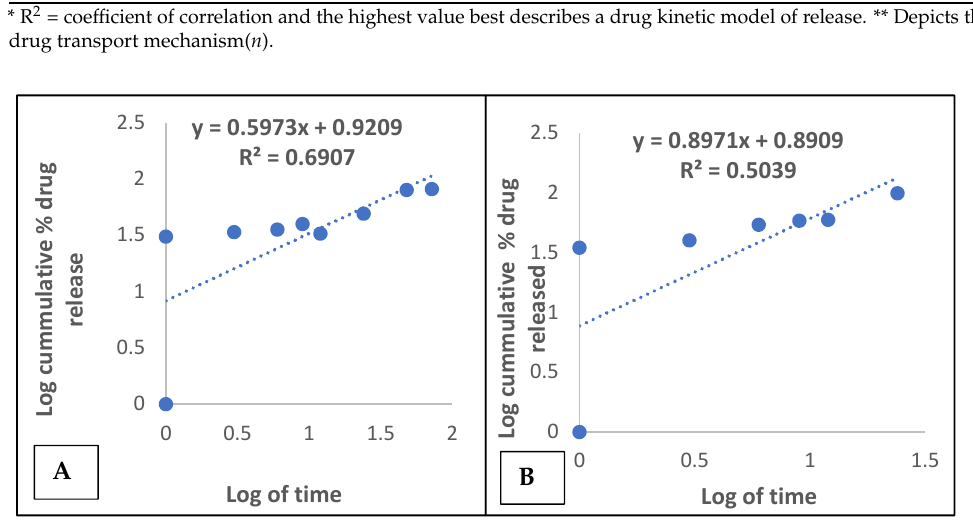
Figure 1: (A) Zero-order kinetic release of maraviroc from microspheres. (B) First-order kinetic re- lease of maraviroc from microspheres facilitated with enzymes.